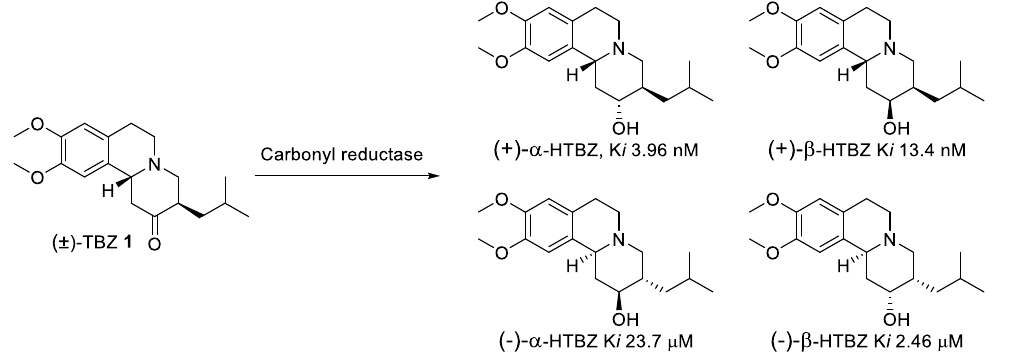
Figure 2 . The metabolism of TBZ and the structures of its major metabolites. Figure 2. The metabolism of TBZ and the structures of its major